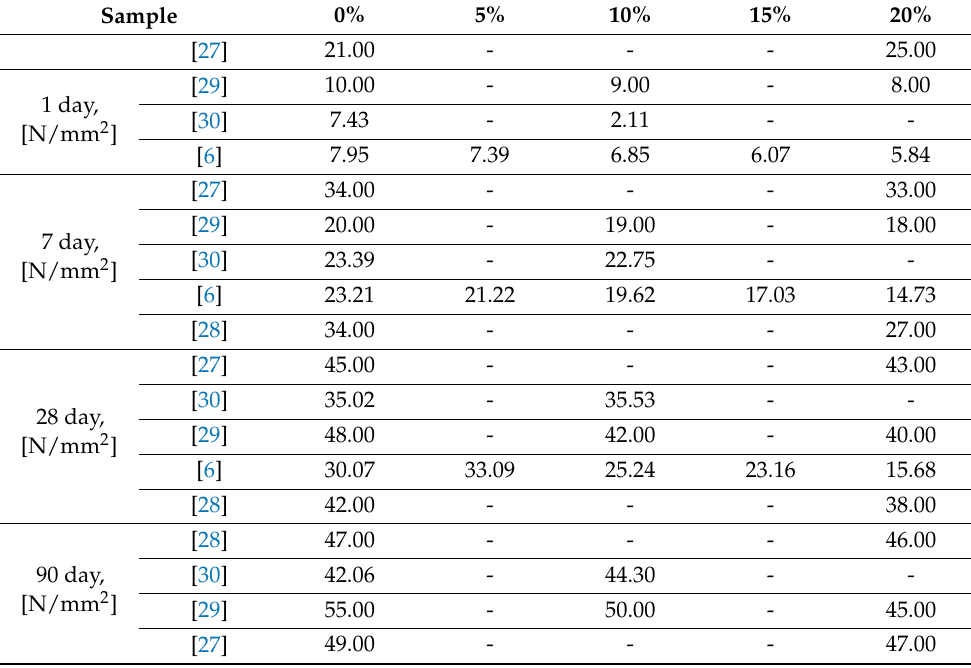
Table 5. Compressive strength for different concentrations